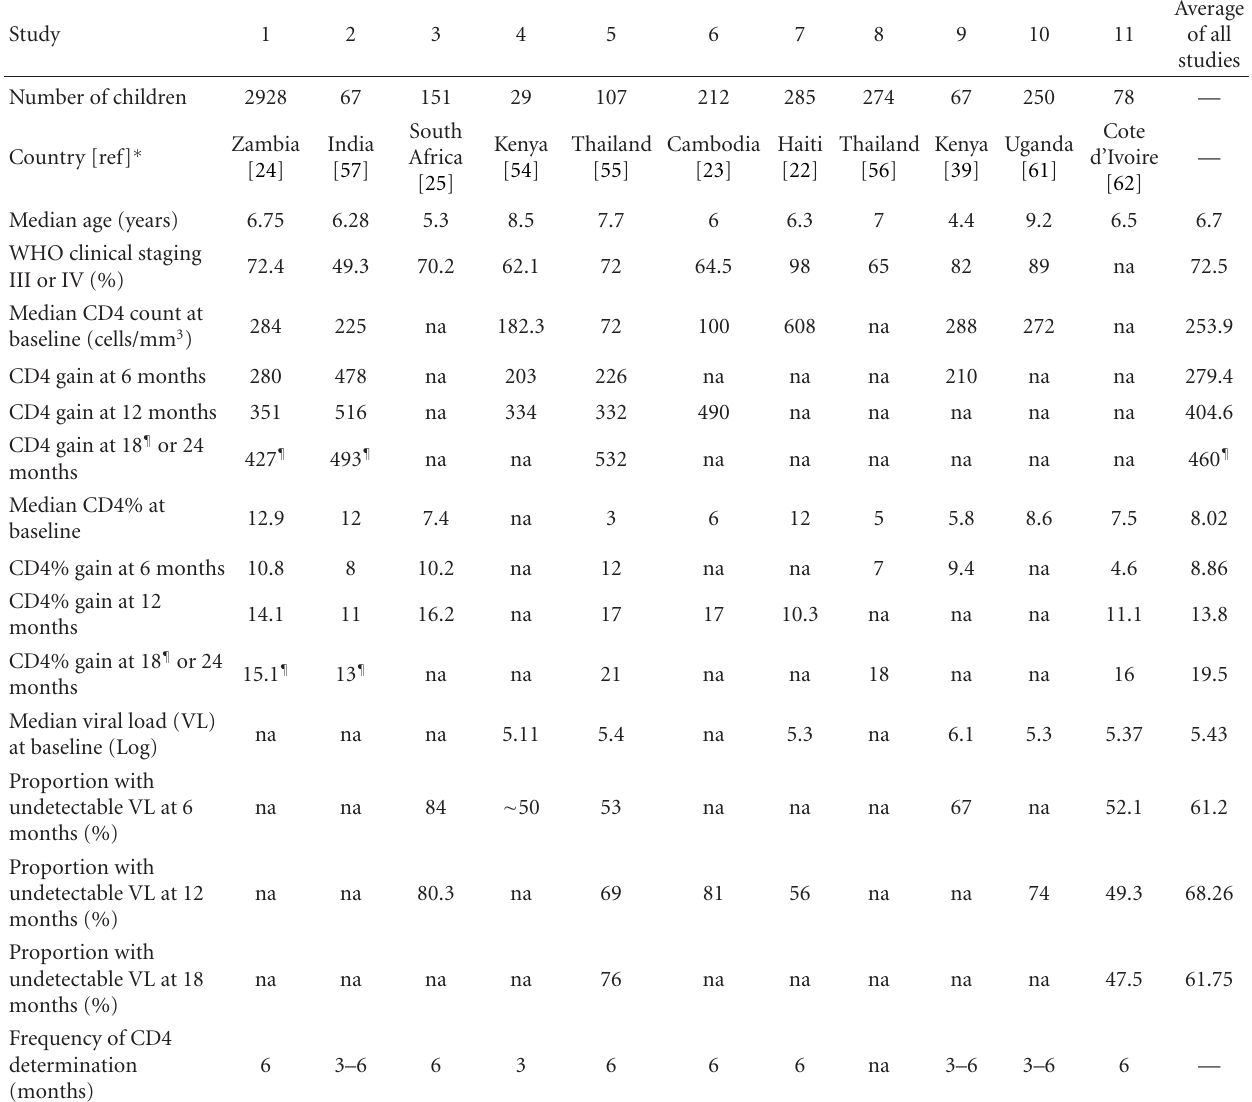
Table 2: Immunologic and virologic outcomes of antiretroviral therapy in HIV-infected children in resource-limited